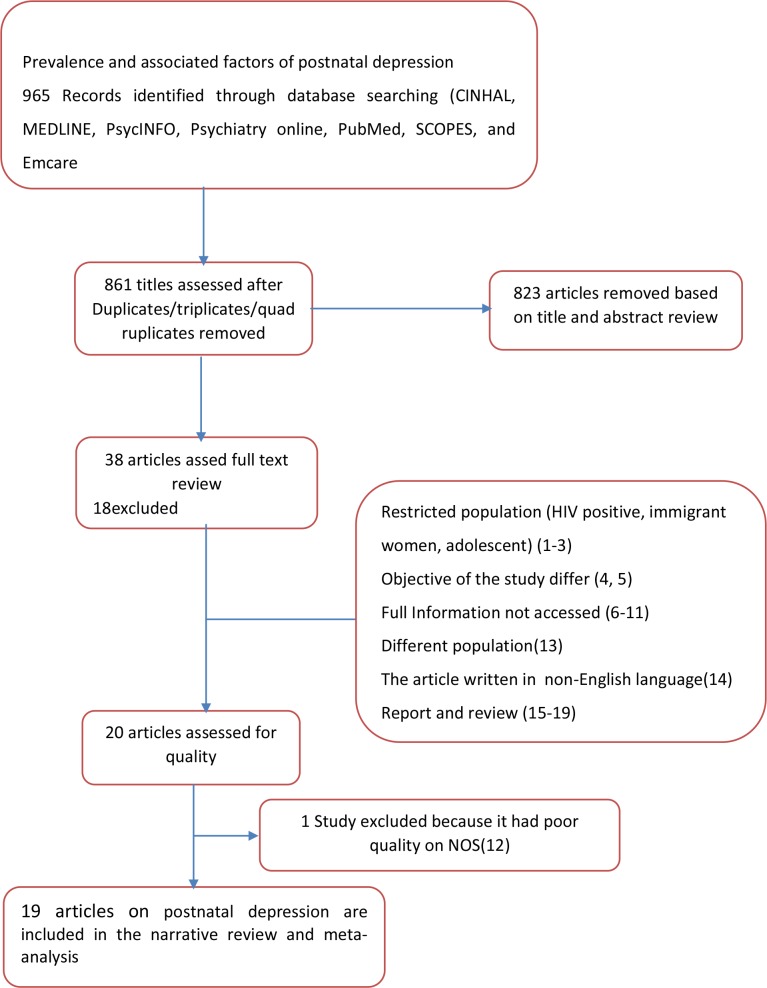
PRISMA flow diagram indicating the study selection for inclusion in the systematic review.